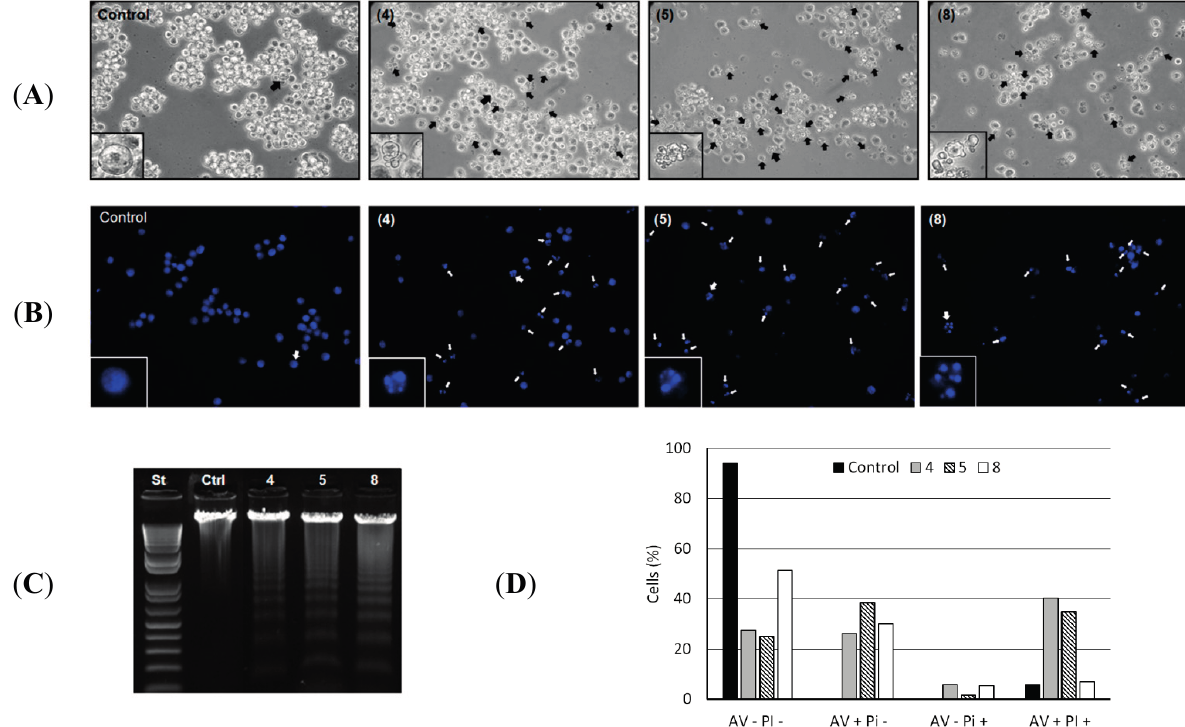
Figure 2. ( A ) Morphological changes induced by 4 , 5 and 8 . HL-60 cells were incubated with 50 µg/mL of each compound for 24 h and analyzed by light microscopy. The formation of blebs in cell membrane was evidenced in all HL-60 treated cells. Magnification ×400; ( B ) Chromatin condensation and fragmentation analysis by fluorescence microscopy. 1 × 10 5 HL-60 cells were incubated with 50 µg/mL of 4 , 5 and 8 for 24 h and stained with DAPI (blue) for chromatin analysis (original magnification, ×400). White arrows indicate chromatin condensation and fragmentation process; ( C ) DNA analysis of HL-60 cells after incubation with 50 µg/mL of 4 , 5 and 8 for 24 h. DNA was extracted from tumor cells and analyzed in 1% agarose gel; ( D ) Translocation of phosphatidylserine in B16F10-Nex2 (5 × 10 5 cells) previously incubated with compounds 4 , 5 and 8 at 100 µg/mL and negative control (RPMI medium) for 24 h. AV − PI − (live cells); AV+PI − (early apoptotic cells); AV − PI+ (necrotic cells); AV+PI+ (late apoptotic